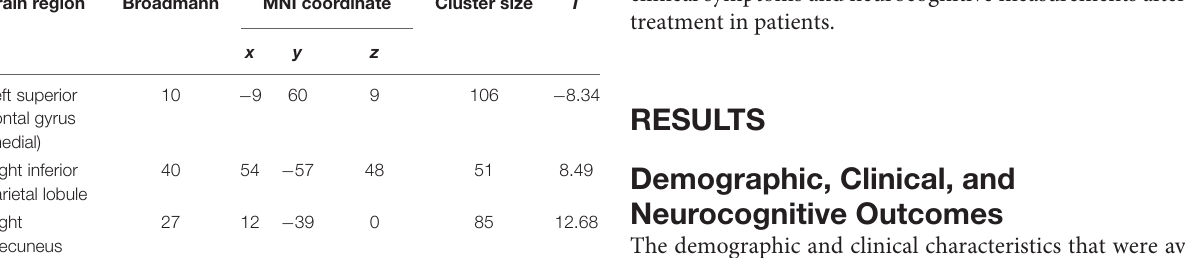
TABLE 2 | Amplitude of low-frequency fluctuation differences between the patient and control group at baseline. Brain